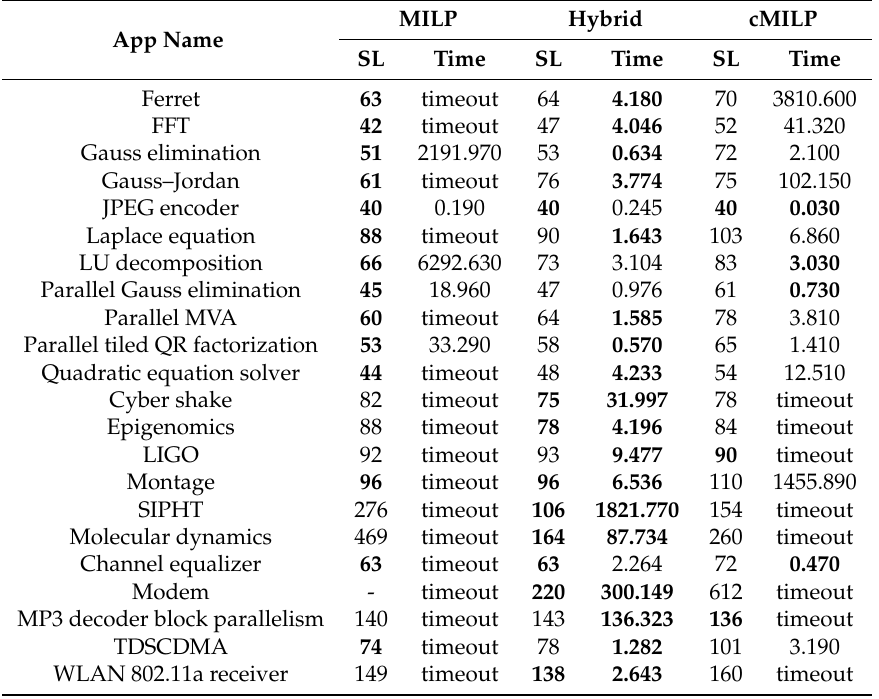
Table 4. Sw/Hw partitioning and scheduling result of the set of real applications on the platform with 70% resource. cMILP, cluster-based MILP; SL, schedule